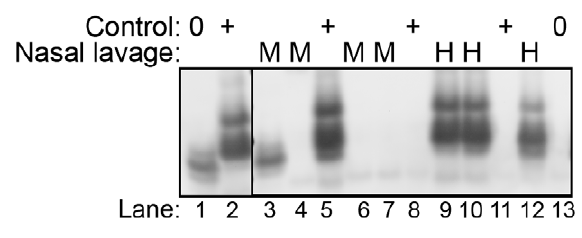
Figure 6. Western blot detection of HY TME infection in nasal lavages using the QuIC assay. Nasal lavages (2 m l) from mock- (M)(lanes 3, 4, 6, and 7 correspond to the four mock-infected samples from Table 3) and HY TME (H) -infected hamsters (lanes 9, 10, and 12 correspond to HY TME i.ob. # 1 to # 3 in Table 3) were subject to two serial rounds of the QuIC assay in order to detect low levels of PrP Sc . PK- resistant PrP polypeptides between 11 and 17 kDa were observed in the HY TME nasal lavage samples indicating amplification of PrP Sc . In mock-infected nasal lavage samples either no polypeptides or occassionally lower molecular weight polypeptides ( # 12 kDa) were observed, but the latter were not observed in prion-positive control samples. Controls include mock-infected hamster brain homogenates at a 10 2 2 and 10 2 6 dilution (lanes 1 and 13, respectively), HY TME hamster brain at a 10 2 6 , 10 2 8 , and 10 2 10 dilution (lanes 5, 8, and 11, respectively), and 100 femtogram of purified PrP Sc from 263K scrapie infected hamster brain (lane